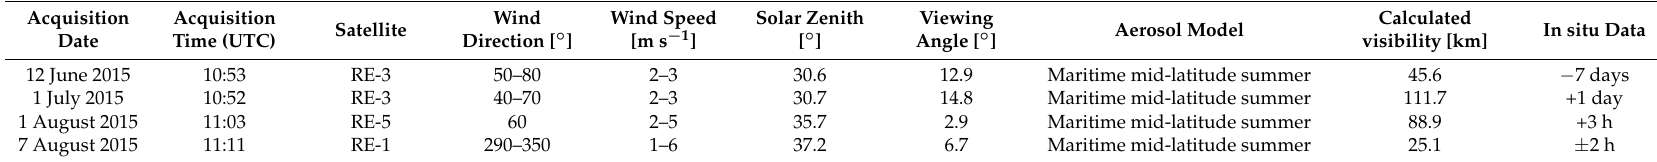
Table 1. Settings of atmospheric correction, solar and sensor geometry and weather conditions close to image acquisition ( ± 1